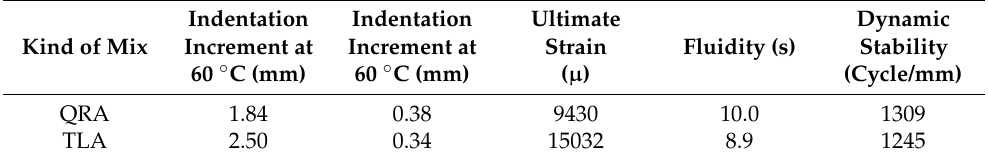
Table 7. Performance of two kinds of